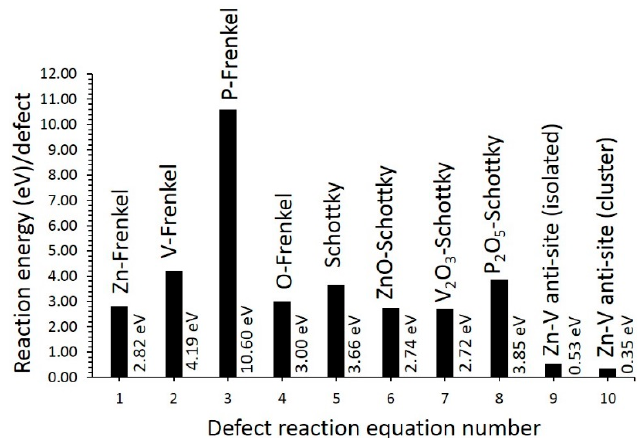
Figure 2. Energies of defects for different defect processes in Zn 3 V 4 (PO 4 ) 6